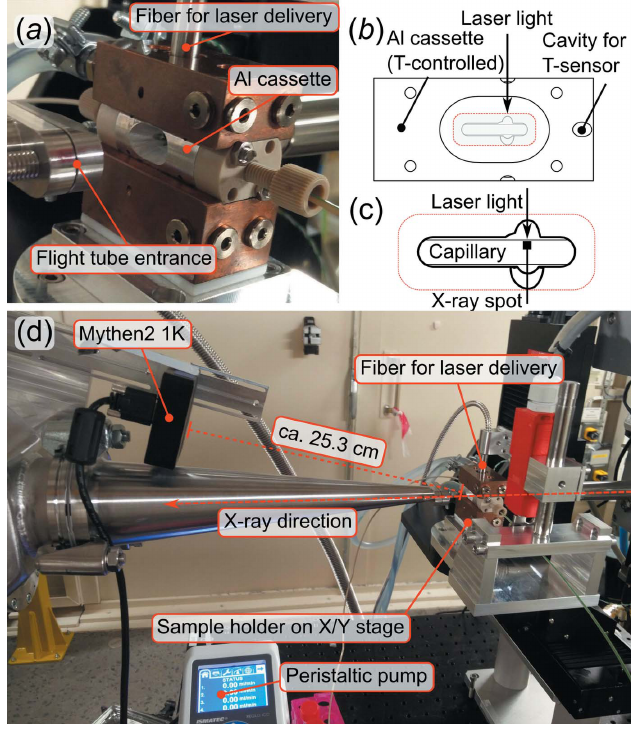
Figure 1 Flow cell and environment at the CoSAXS experimental table. ( a ) The flow cell capillary holder. ( b ) The aluminium cassette of the capillary holder and ( c ) a close up indicating where the X-rays and laser are directed. The size of the laser spot is (cid:2) 0.9 mm FWHM and the X-ray spot is (cid:2) 160 m m (cid:3) 140 m m. ( d ) The setup at the sample table. Fresh sample is delivered through PEEK tubing by a peristaltic pump. The irradiating laser light arrives through a fiber. The sample holder is placed on an X / Y stage (cid:2) 25 cm from the WAXS 1D detector and 2 m from the 2D SAXS detector (outside